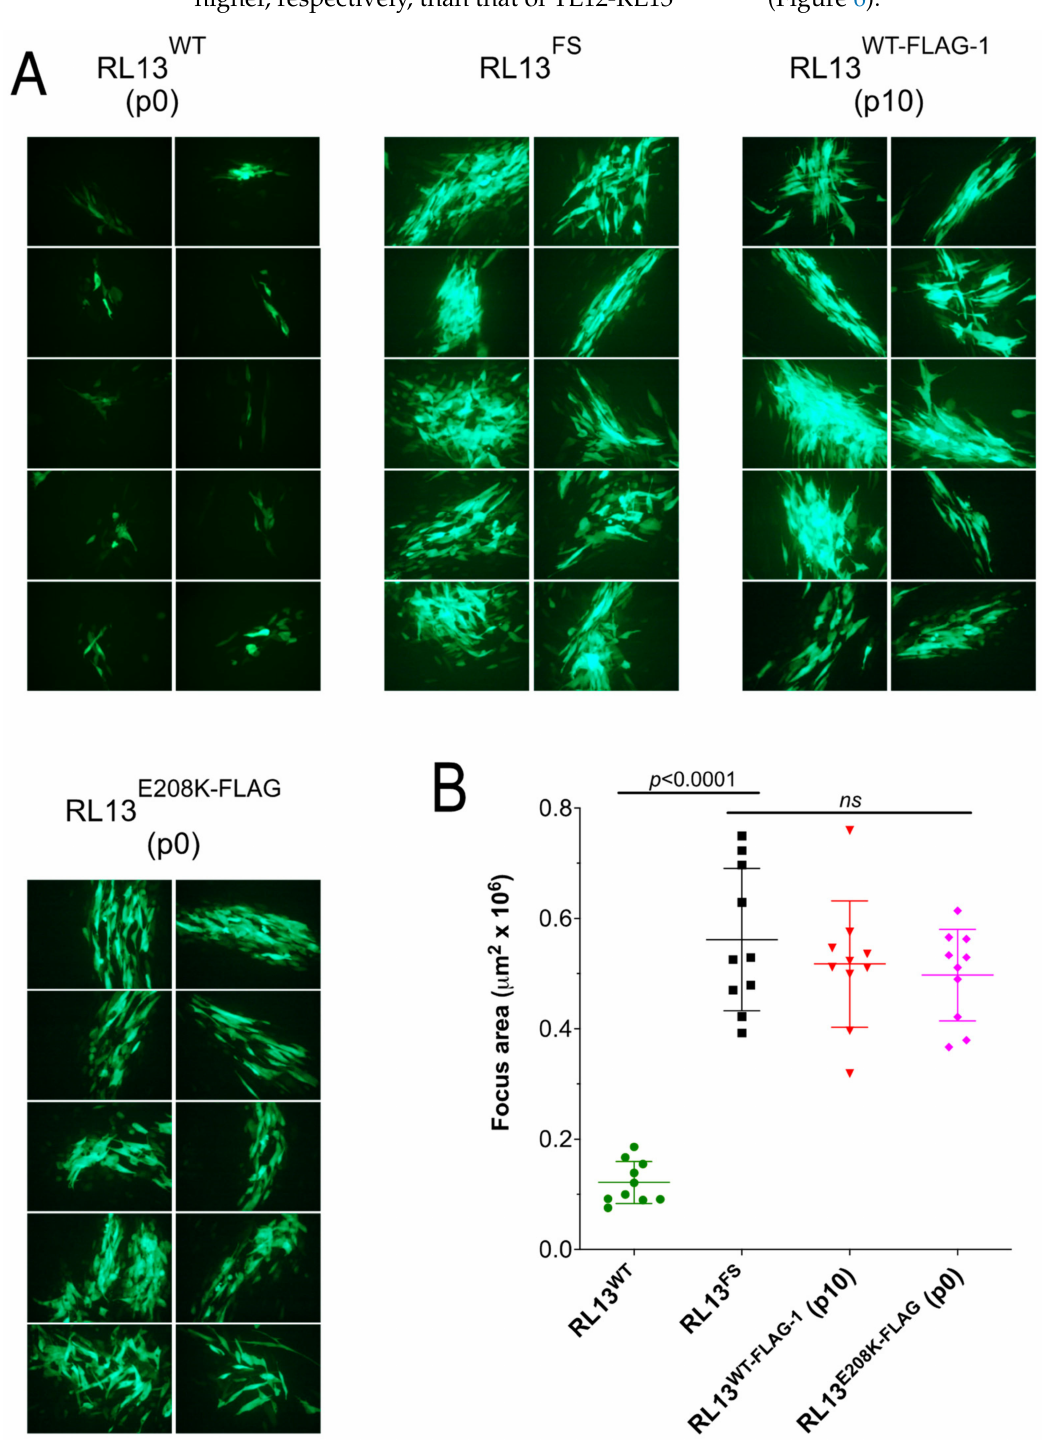
Figure 5. The E208K substitution in RL13 increases focus size. The indicated virus stocks were used to infect MRC-5 fibroblast monolayers at low MOI. After eight days, GFP+ foci were photographed ( A ) and their surface areas measured ( B ) as described for Figure 2 ( p values from Student’s two-tailed t -test; ns , not significant.). Original magnification: 100 ×